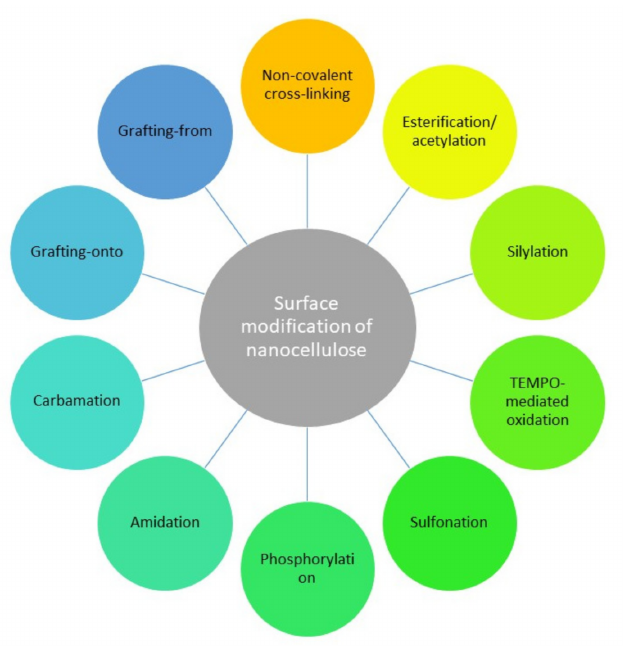
Figure 4. Surface modification methods of nanocellulose (summarized from Ghasemlou et al.